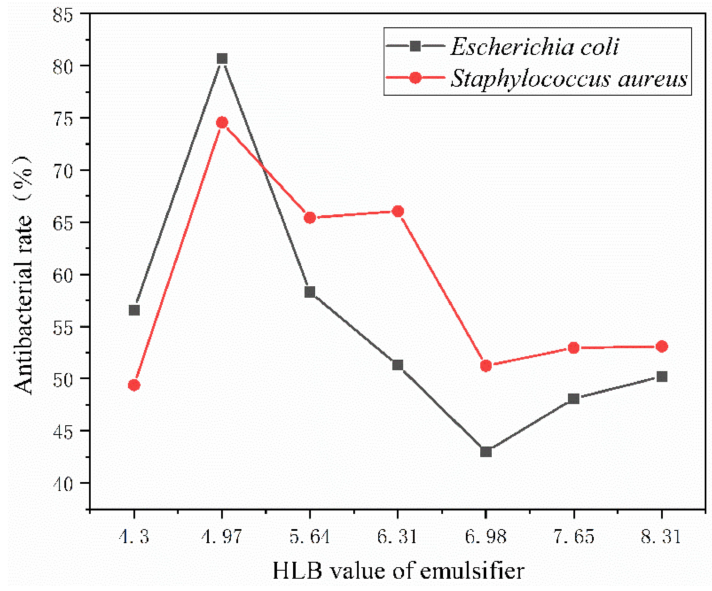
Figure 8. The antibacterial rate of coating film on glass substrate surface.